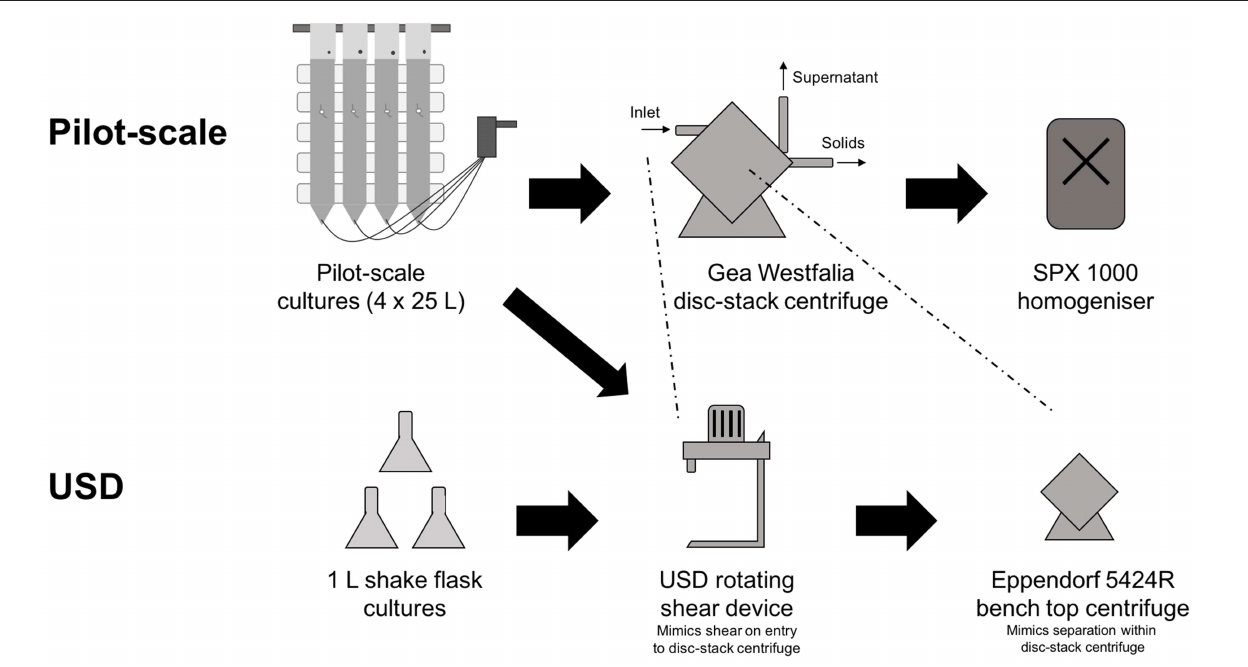
FIGURE 1 | Flow sheet outlining the processing steps involved in both pilot-scale and USD studies. Pilot-scale cultures of Chlamydomonas reinhardtii TN72_pal were grown in a 4 × 25L modular hanging bag photobioreactor system before harvest with Gea Westfalia continuous-flow, intermittent-discharge disc-stack centrifuges. Disruption of the cellular component at pilot-scale was performed using a SPX 1000 homogenizer. In the USD study, cultures were grown in 1L shake flasks or the hanging bag system and then processed using the USD rotating shear device to mimic the shear cells are subject to upon entrance into the Gea Westfalia disc-stack centrifuge. Subsequently, a bench top centrifuge was used to mimic the separation of cells from culture media that occurs within the pilot-scale